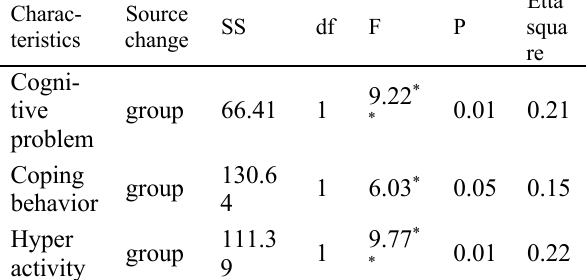
Table 5. Summary results of the analysis of covariance to the effect on eye movement's intervention to reduce symptom characteristics of ADHD boys.